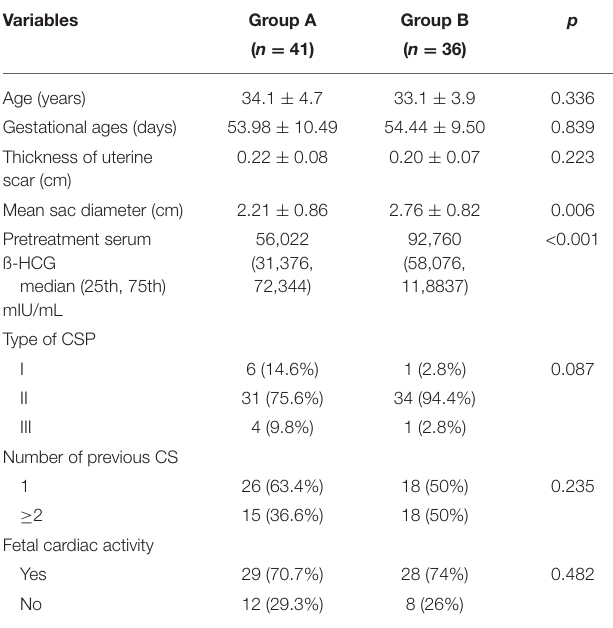
TABLE 1 | Demographic and clinical characteristic of patients with CSP.